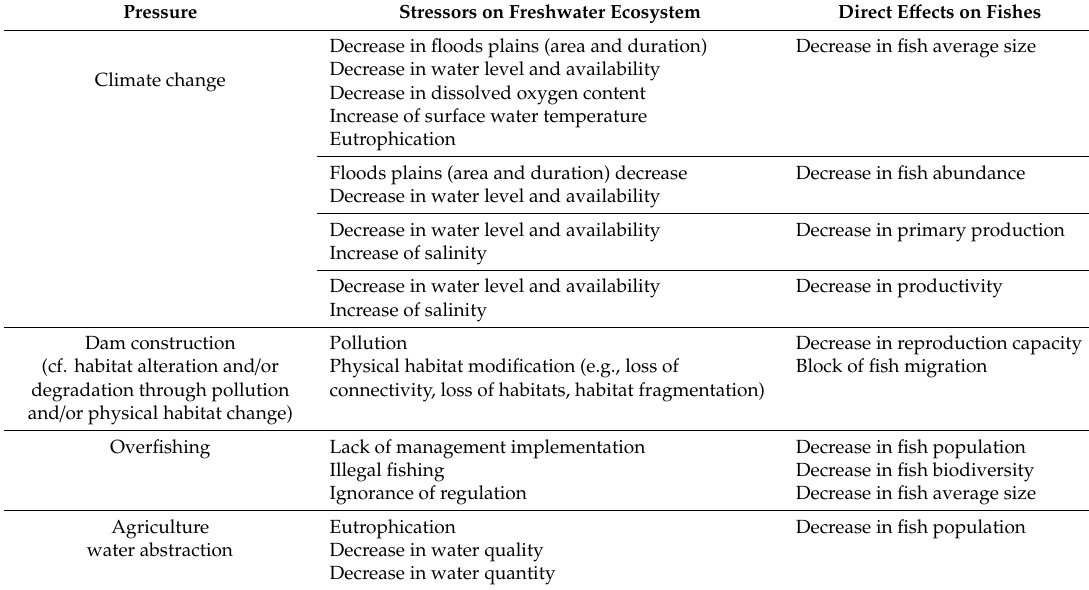
Decrease in fish average size Decrease in fish abundance Decrease in primary production Decrease in productivity